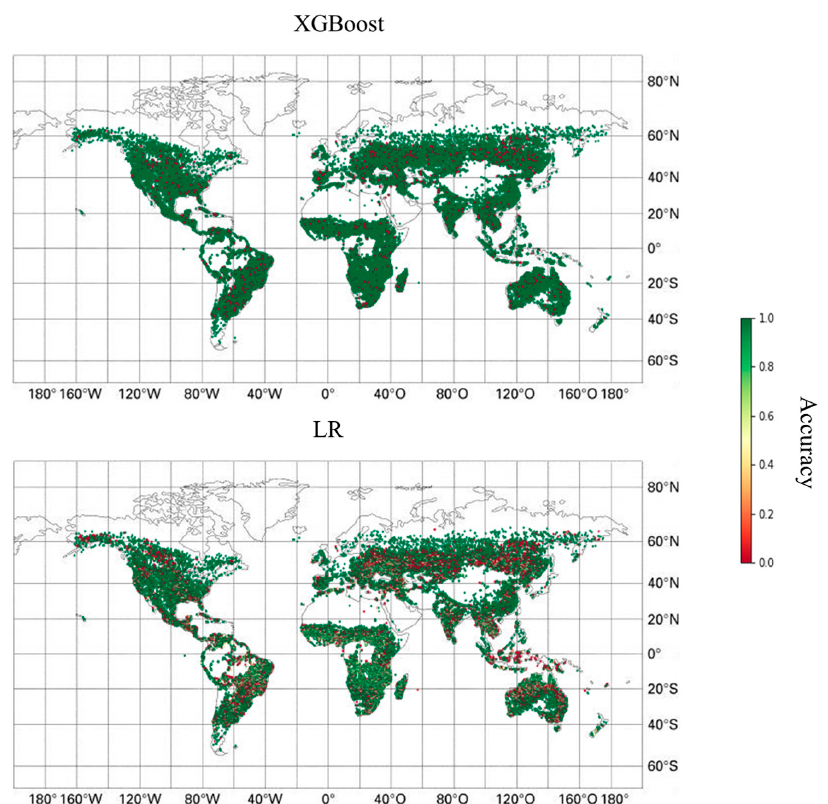
Figure 3. ROC curves—wildfire occurrence classification. ROC curves of the four models used for wildfire occurrence prediction. The figure refers to the models which include wildfire history variables; a similar figure for models without the wildfire history variables is presented in Appendix A (Figure A1). The XGBoost model has the best prediction performance with an AUC score of 0.97 (on a scale of 0 to 1). The random forest model performance is slightly lower with an AUC of 0.92. The accuracy of the MLP model is significantly lower and is even slightly lower than the logistic regression.